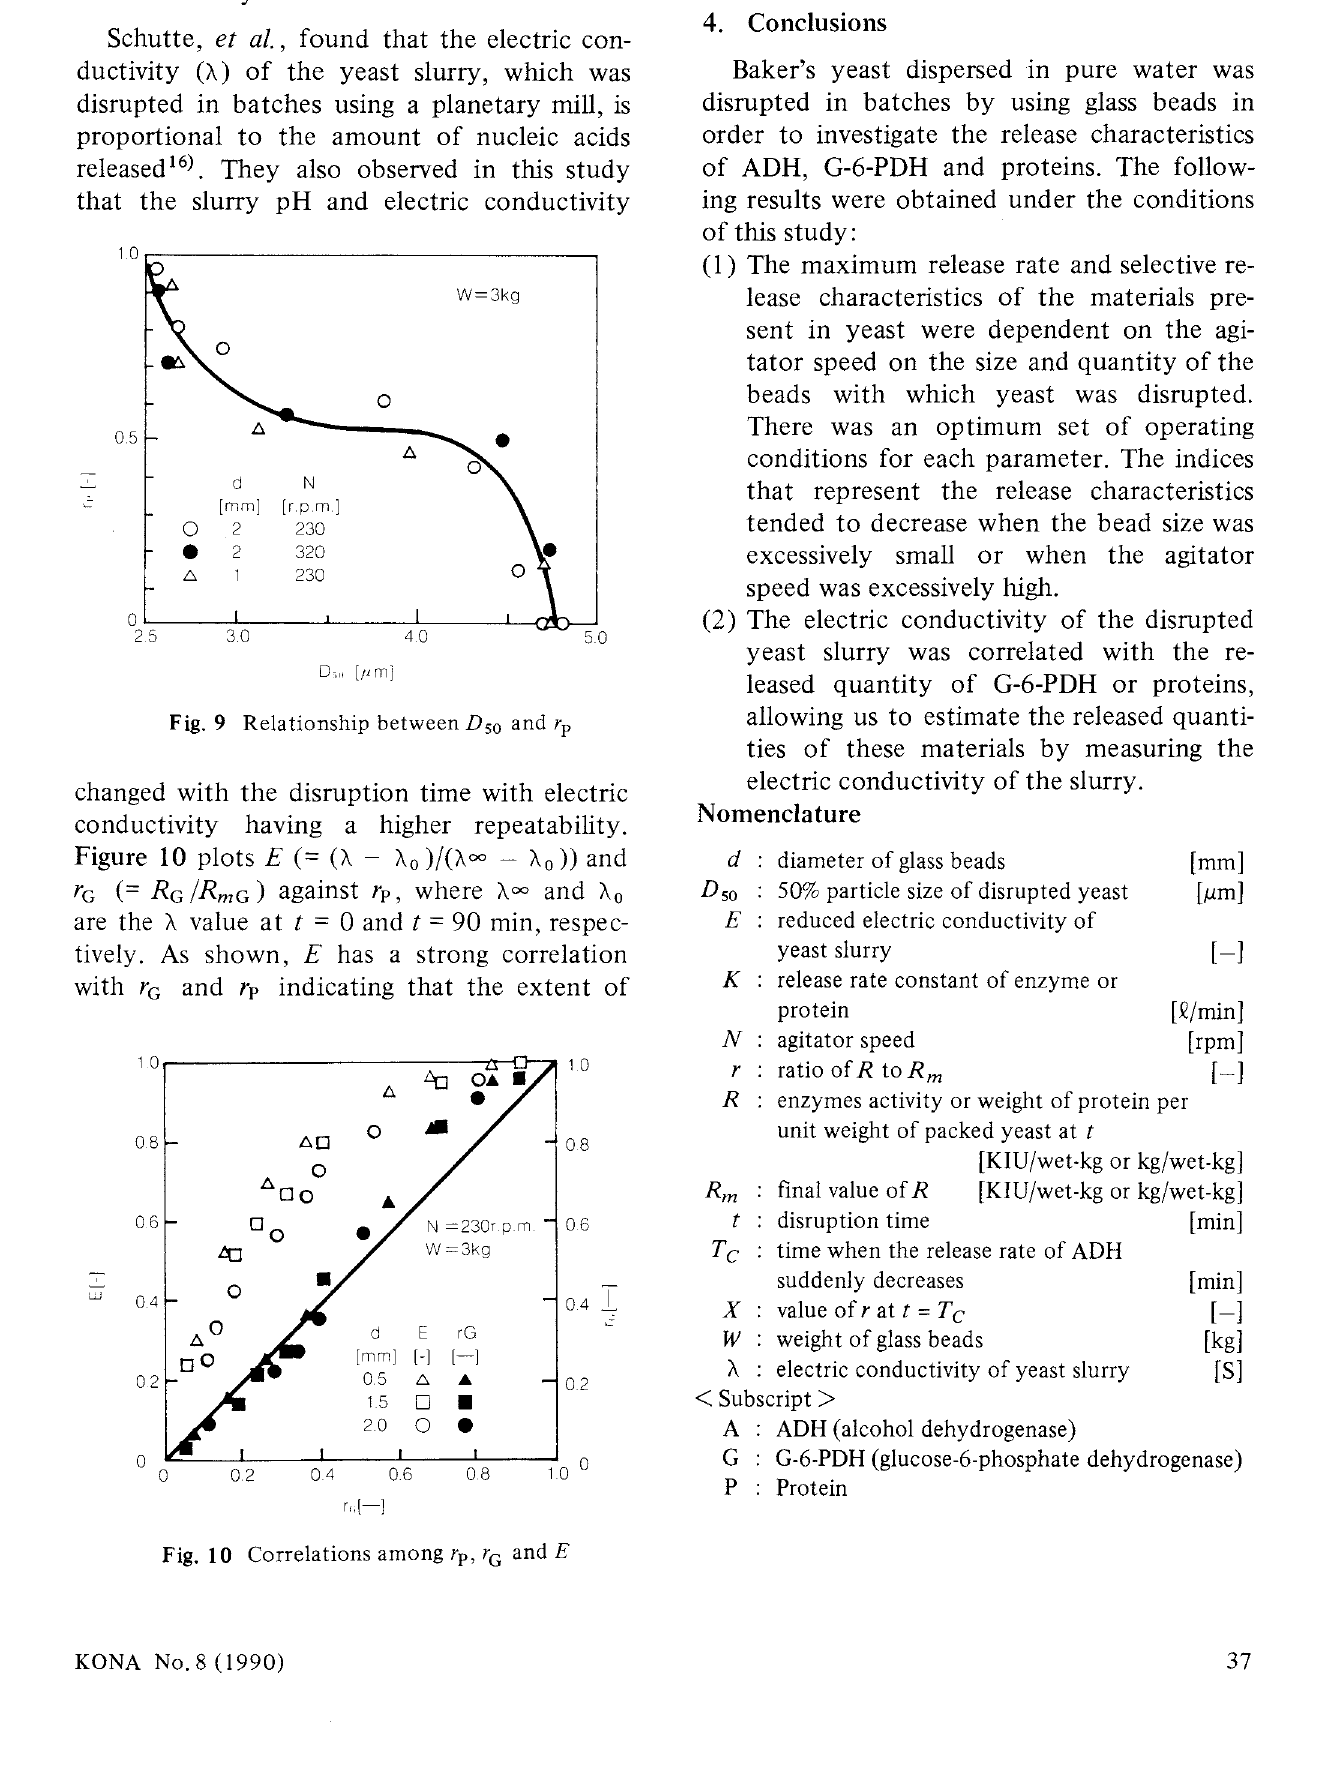
Fig. 10 Correlations among rp, rc and